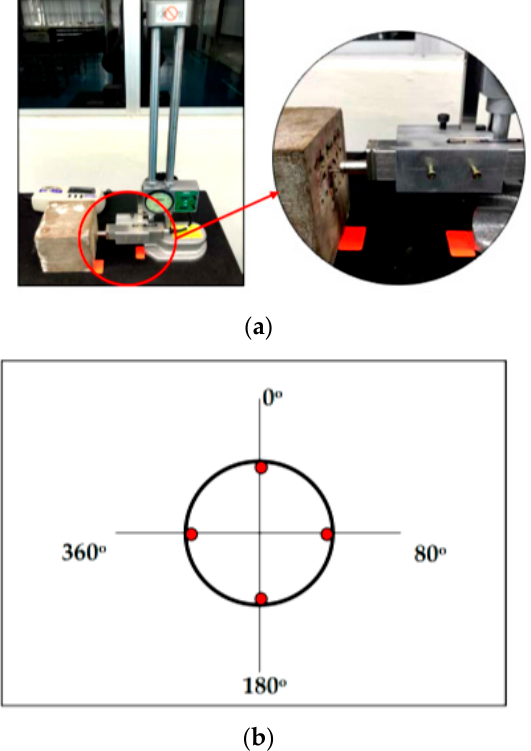
Figure 4. ( a ) The location of surface roughness measurement and ( b ) location of measurement.